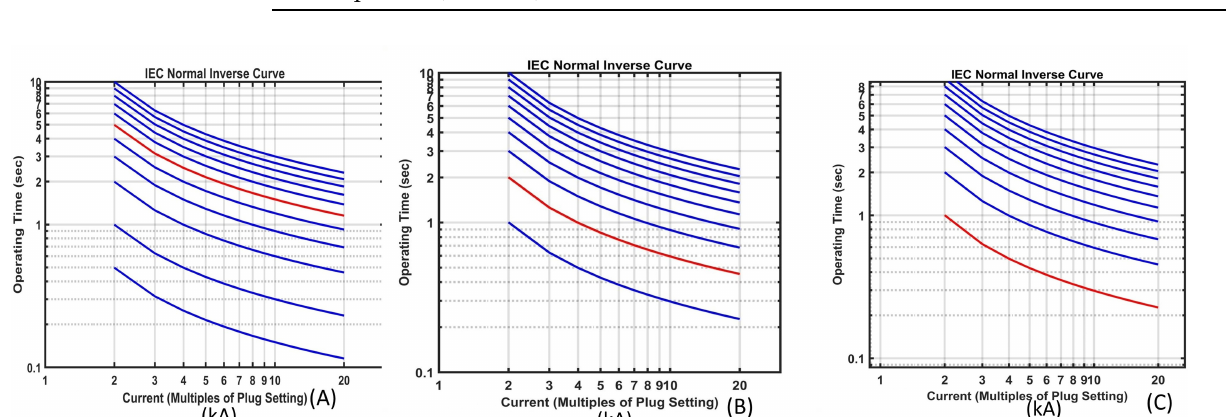
Figure 3. Time multiplier settings at 1